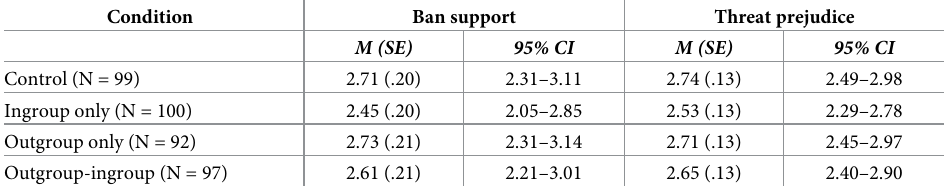
Table 2. Means, standard errors, and 95%